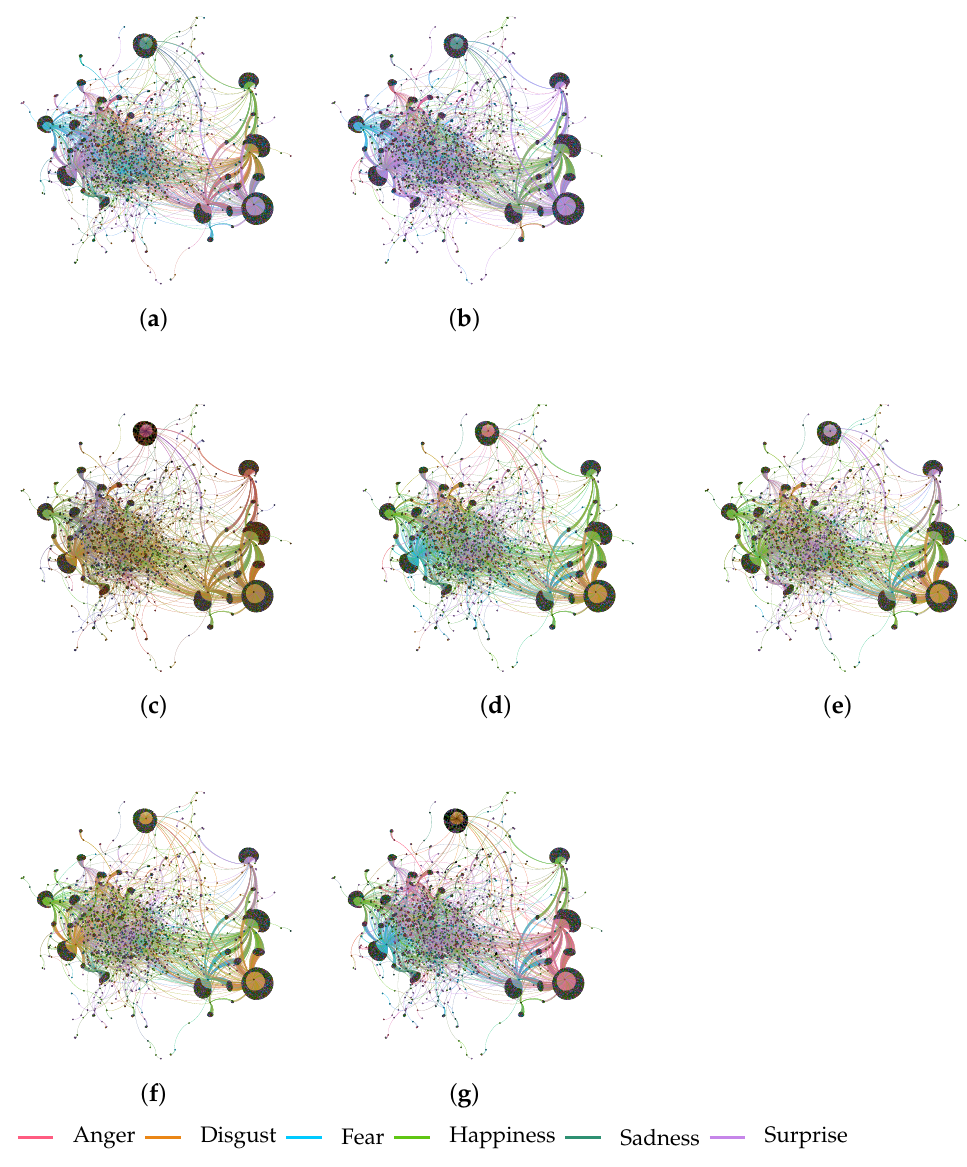
Figure 14. Visualization of emotion prediction with different methods on Microblog ( a )